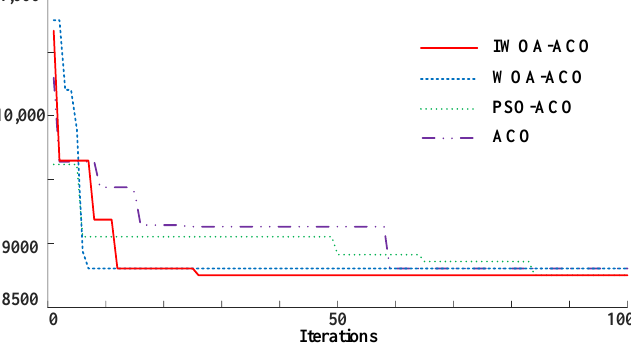
Figure 10. The iterative path length convergence curve in the simulation of flat environment.